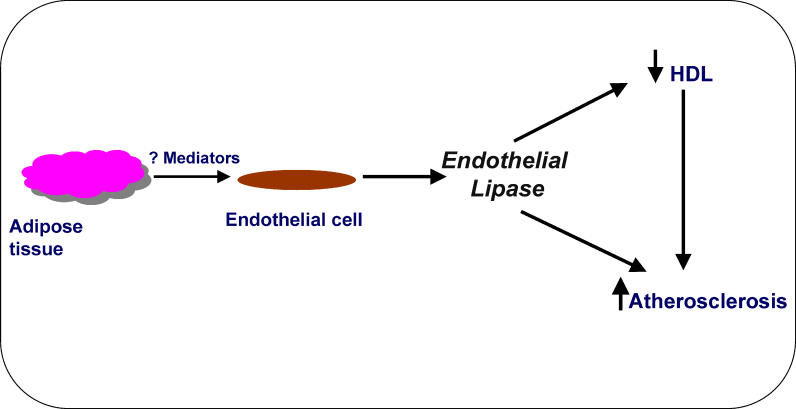
Endothelial lipase and atherosclerosis